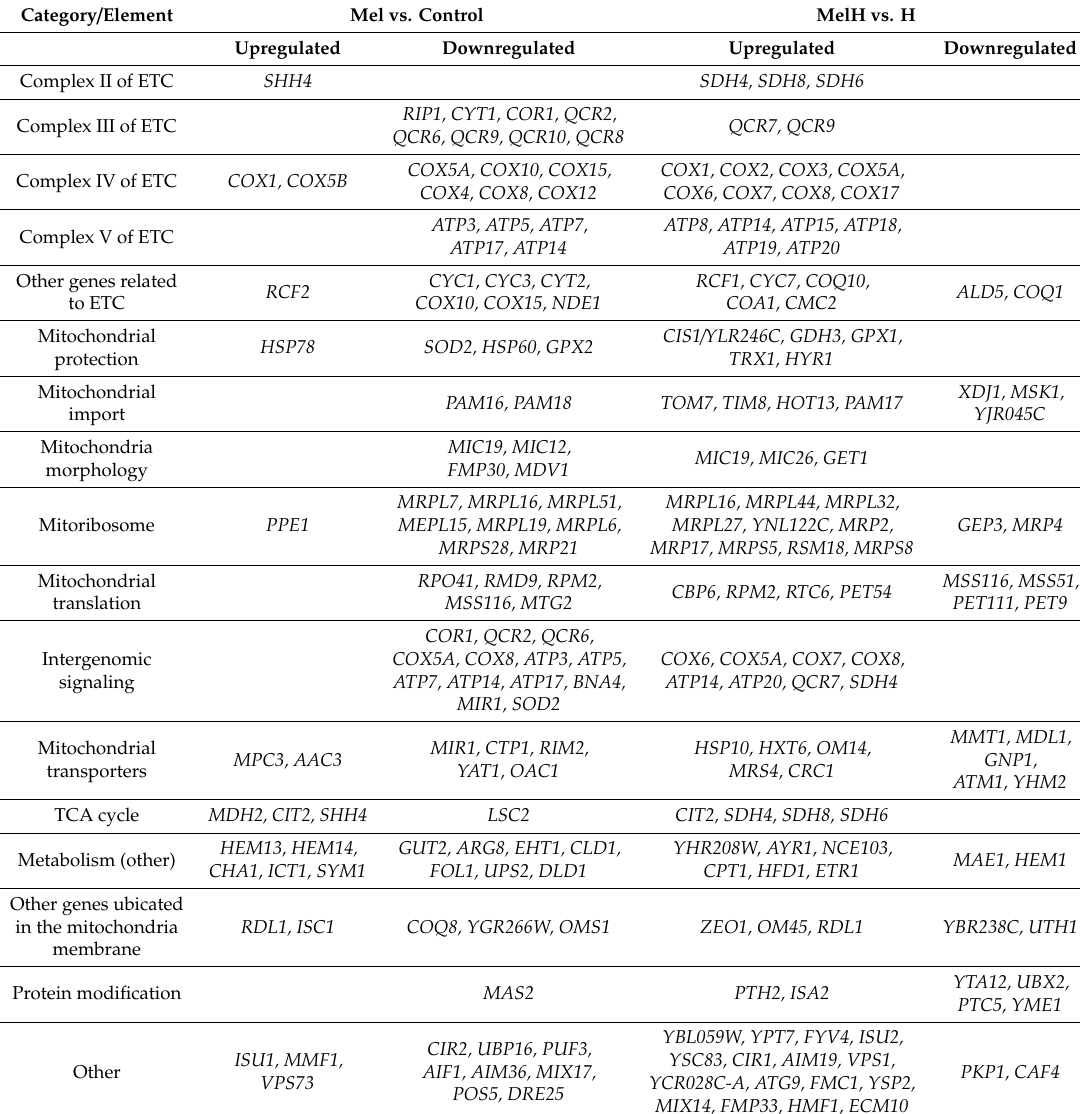
Table 3. List of mitochondrial genes regulated by melatonin in nonstressed cells (Mel vs. Control) and stressed cells (MelH vs. H). The fold change and p -values are provided in Datasets S1 and S4. They are classified into di ff erent categories, and the genes that were upregulated and downregulated in each condition are